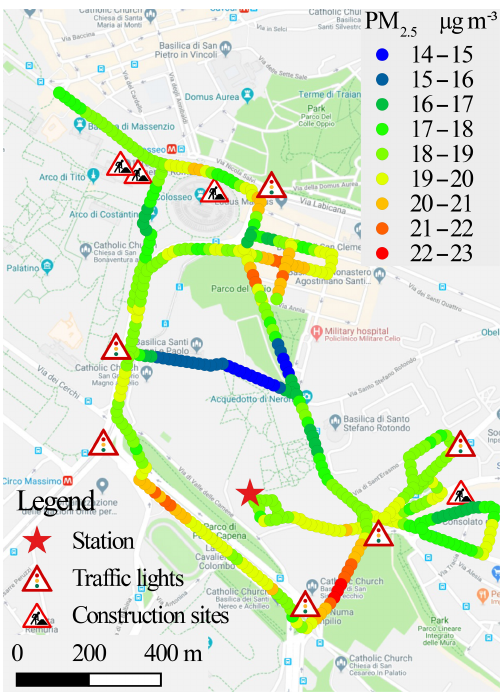
Figure 12. Overall spatial distribution of PM 2 . 5 along the fixed route during the CARE campaign. Map data © Google Maps